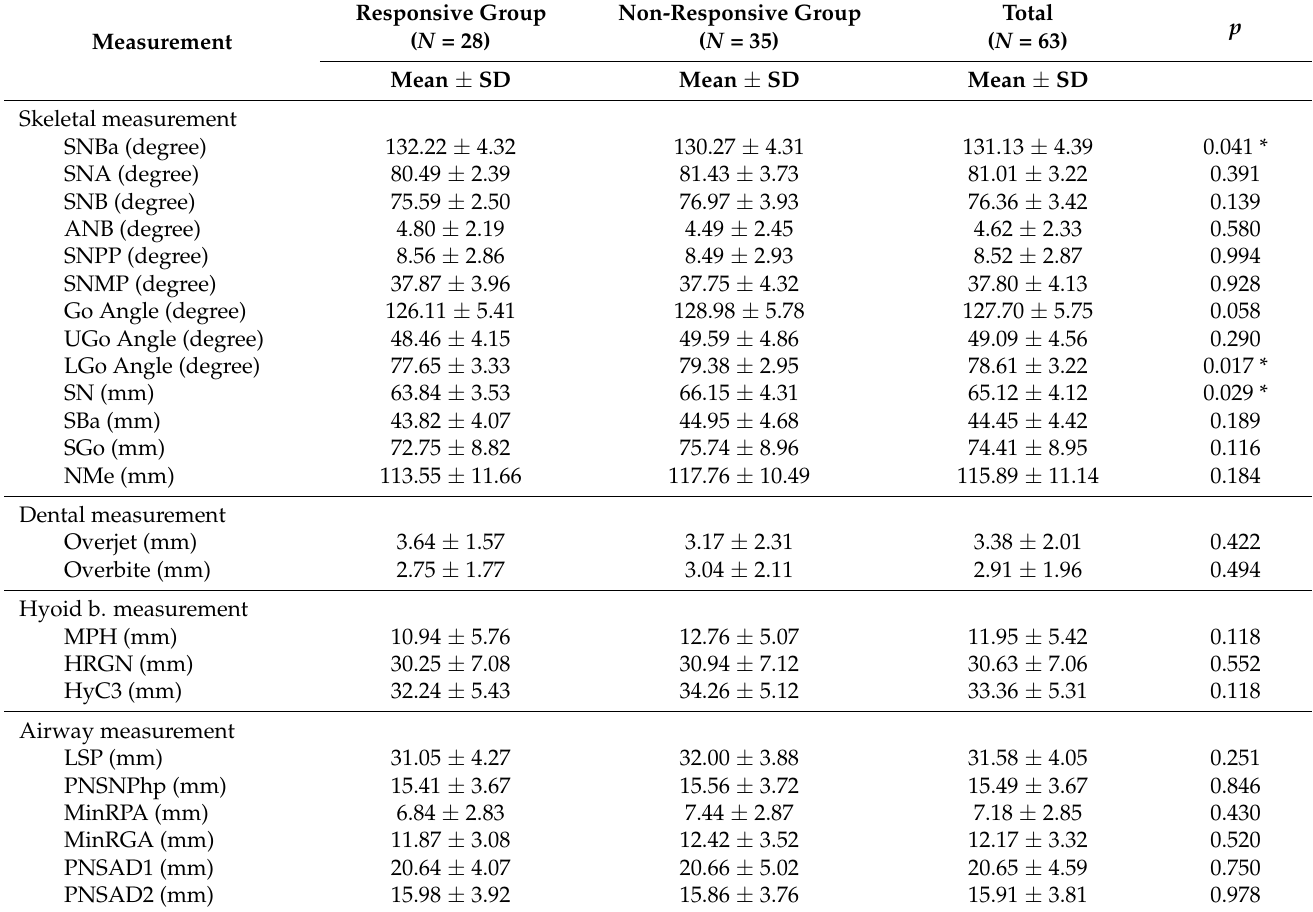
Table 5. Cephalometric analysis: responsive group vs. non-responsive